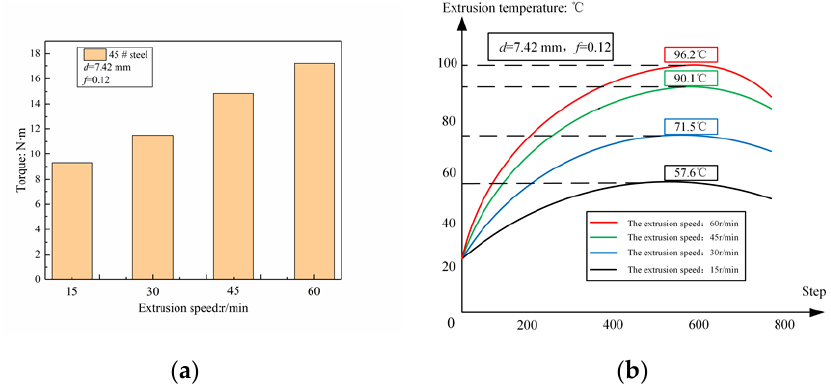
Figure 6. The influence of extrusion speed on torque ( a ) and the influence on temperature ( b ).